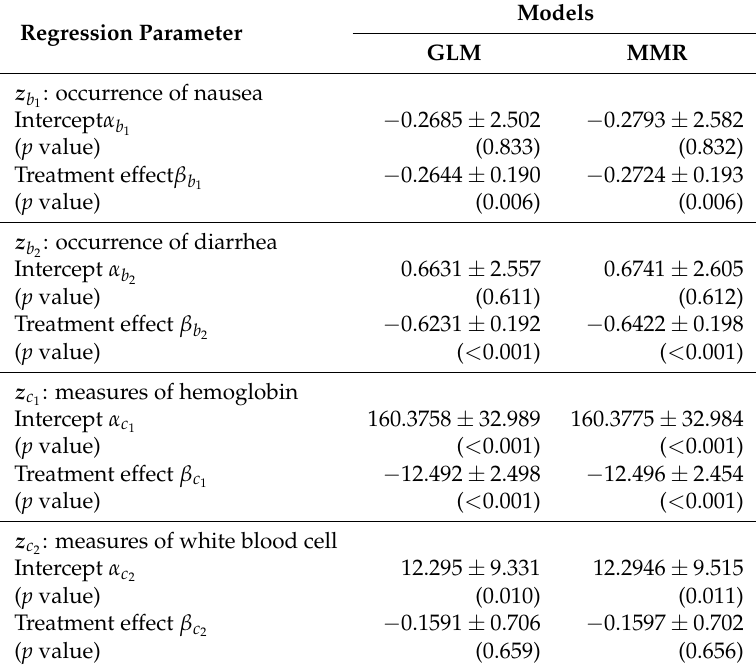
Table 3. The difference in the effect of treatment between the two treatment therapies. GLM: the generalized linear model; MMR: the multivariate mixed response model.